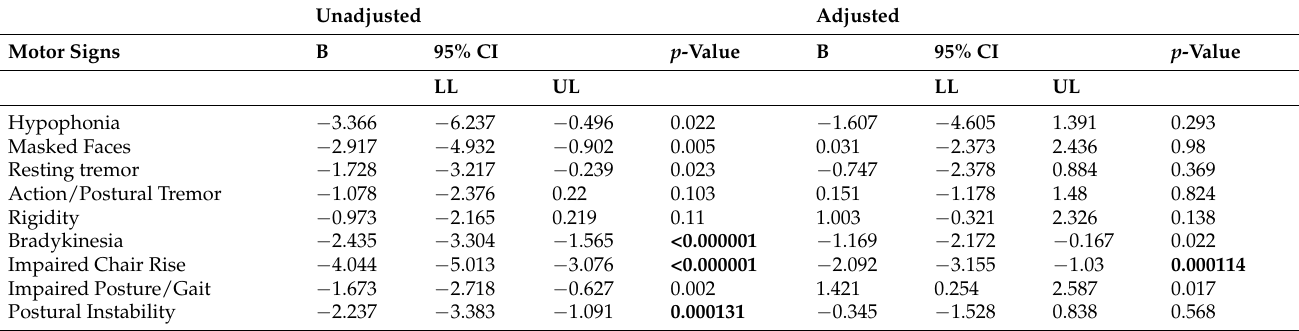
Table 2. Linear regression analysis for association between motor signs and episodic memory. Unadjusted